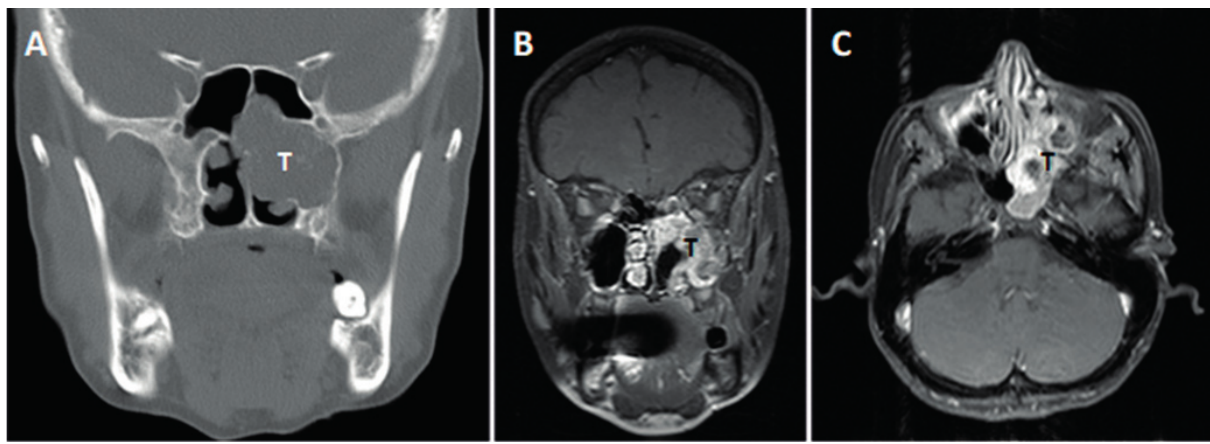
Fig. 1. Preoperative CT and MRI scans of patient 1 show tumor mass in the left maxillary sinus. A - CT scan, coronar reconstruction, bone window. B, C - MRI of Patient 1 after the endoscopic surgery and taking of biopsy, with necessary application of anterior nasal package.